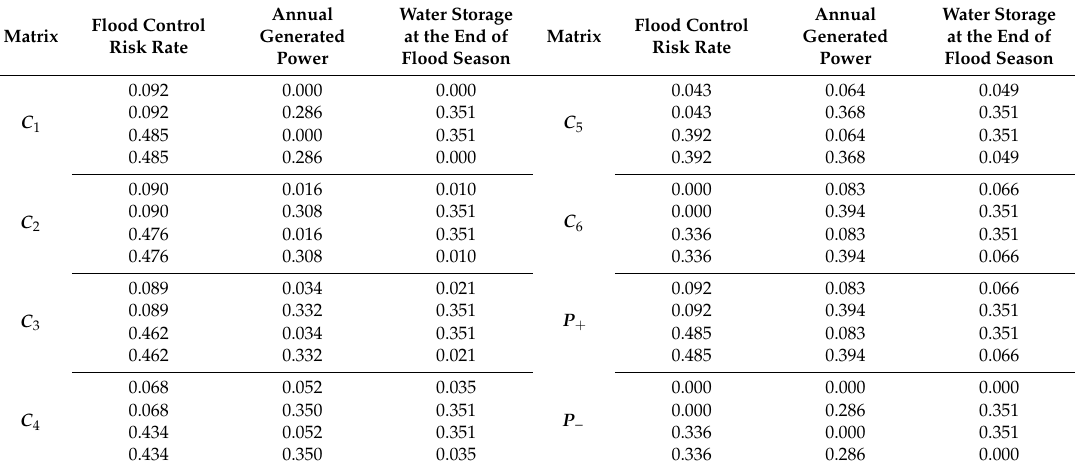
Table 8. Layout matrixes of the